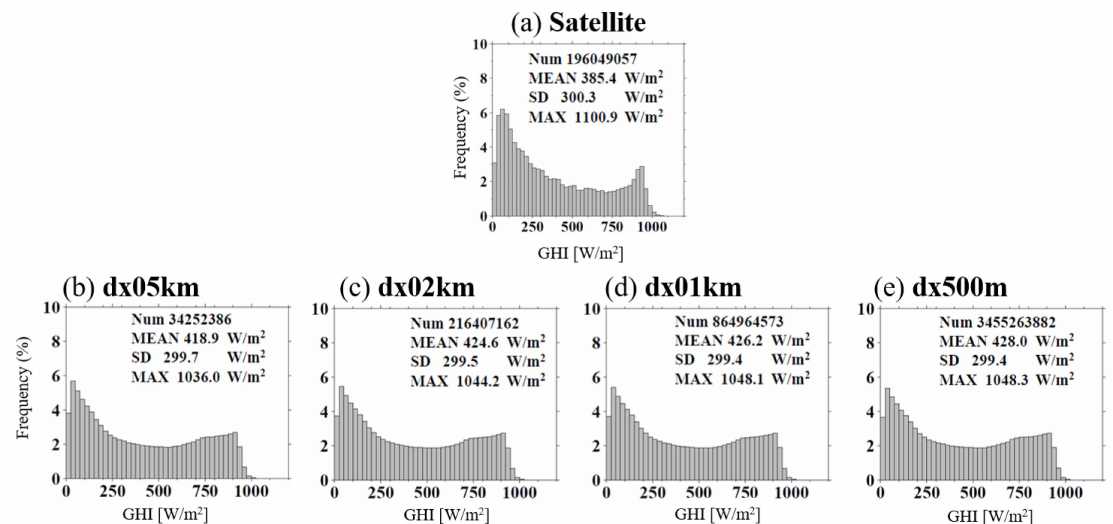
Figure 9. Frequency of ( a ) satellite-derived GHI values for TEPCO area during the two summer months of 2015. Frequency of GHI forecasts (3 h ahead forecast) obtained from ( b ) dx05km, ( c ) dx02km, ( d ) dx01km, and ( e ) dx500m with 00 UTC (09 JST) initialization time. “Num”, “MEAN”, “SD”, and “MAX” in each panel represent data number, mean values, standard deviation and maximum values,